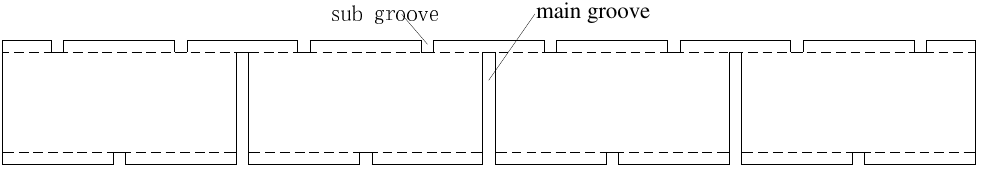
main groove sub groove